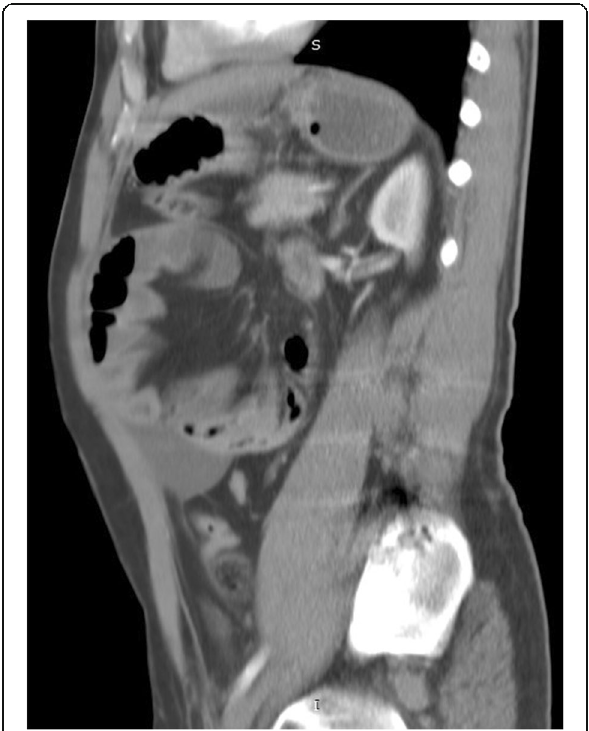
Fig. 3 Left paramidline sagittal reformatted image shows the tight sac containing the small bowel